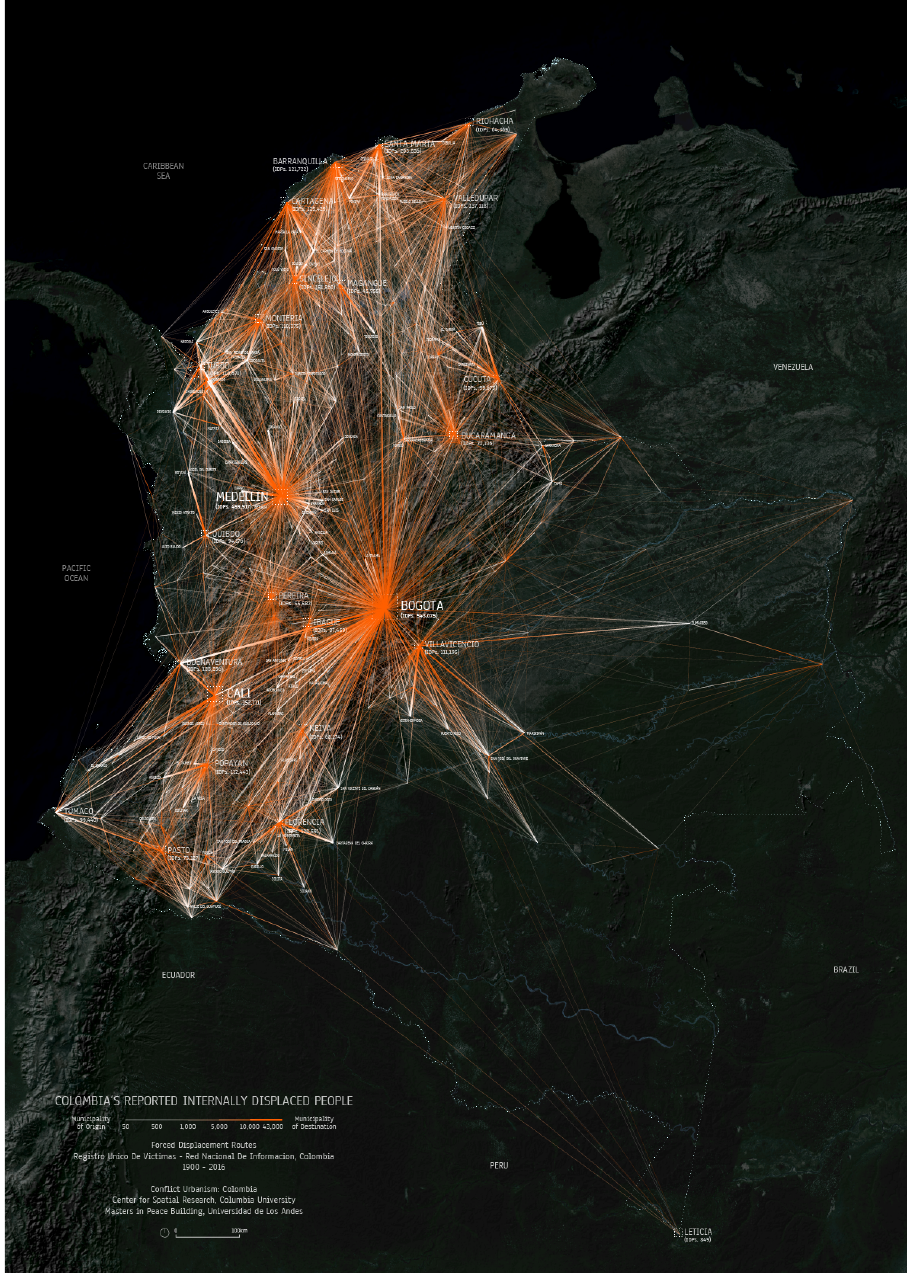
Figure 1. Map of Internally Displaced People